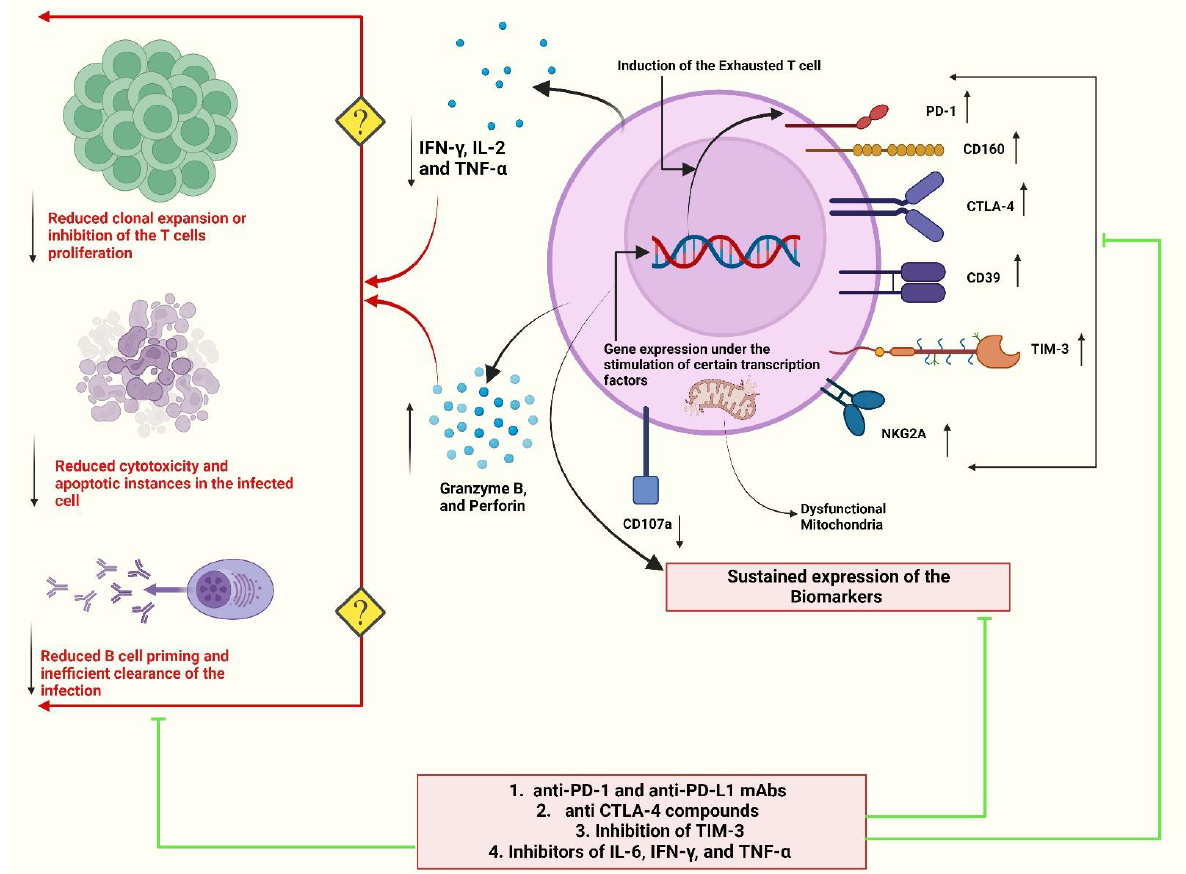
Figure 3. T-cell exhaustion and associated repercussions. Because of persistence antigen exposure and chronic T cell receptor (TCR) signalling, T cell exhaustion or dysregulation is common in severe viral infections. Exhausted T cells have lower proliferation and differentiation rates. Additionally, exhausted CD8+ T cells show reduced cytotoxic activities, altered gene expression, and dysfunctional metabolic activities. The dysfunctional mitochondria are also a key feature of exhausted T cells.